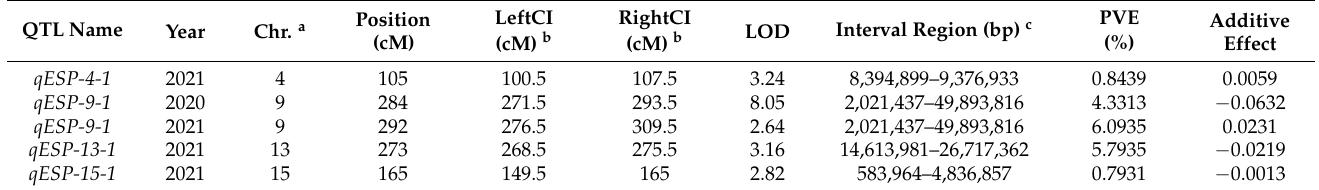
Figure 2. Genetic map of F 2 population and ESP-related QTLs. Ruler on left side indicates interval distance between SNP markers using centimorgan (cM) as the unit, and ESP-related QTLs are annotated to the right of chromosomes. Line at the right of some chromosomes indicates physical QTL region, and horizontal line inside one line indicates confidence interval of QTL region. Table 3. Analysis of ESP-related QTLs in offspring population from JY93 ×